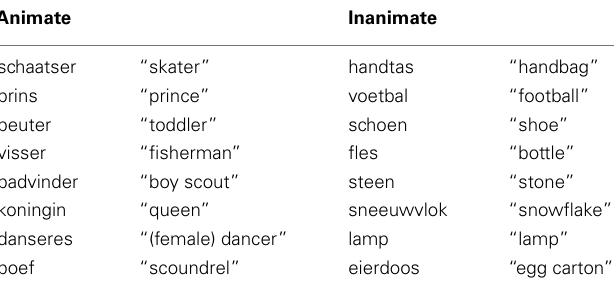
TableA1 | Lexical items used in Experiment 1.